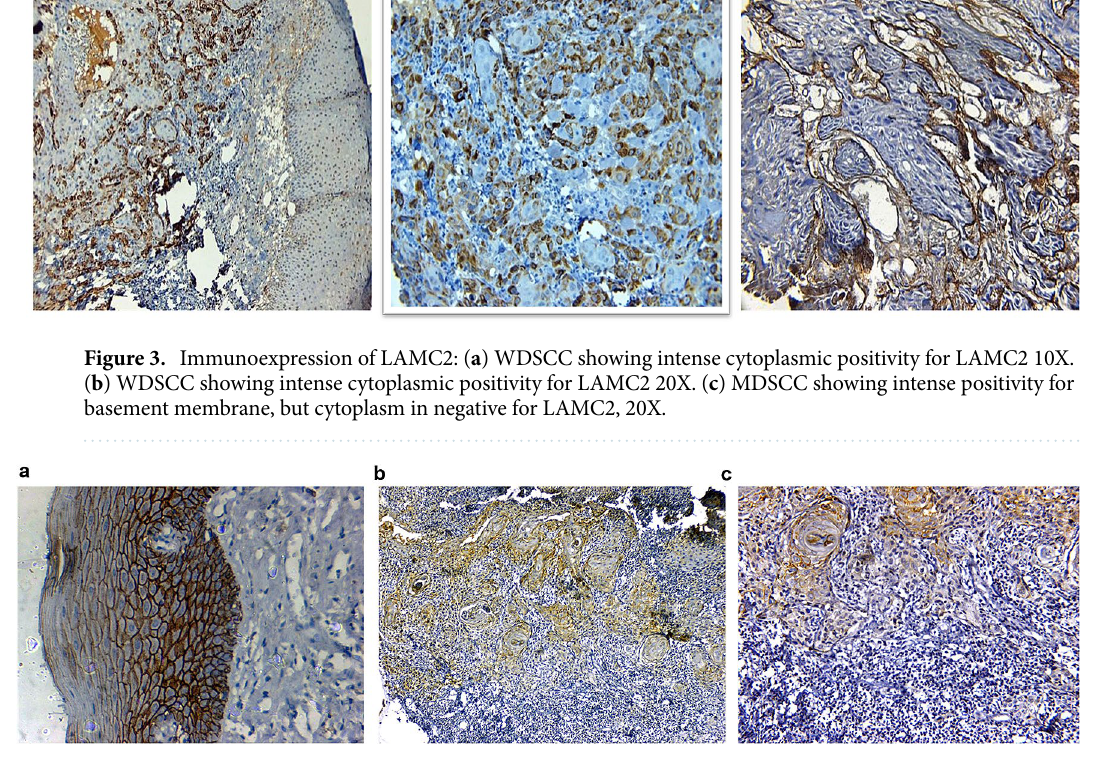
Figure 4. Immunoexpression of ECAD ( a ). Normal epithelium with intense E-cadherin positivity ( b ). Reduction of ECAD expression at ITF 10X ( c ). Reduction of ECAD expression at ITF 20X.